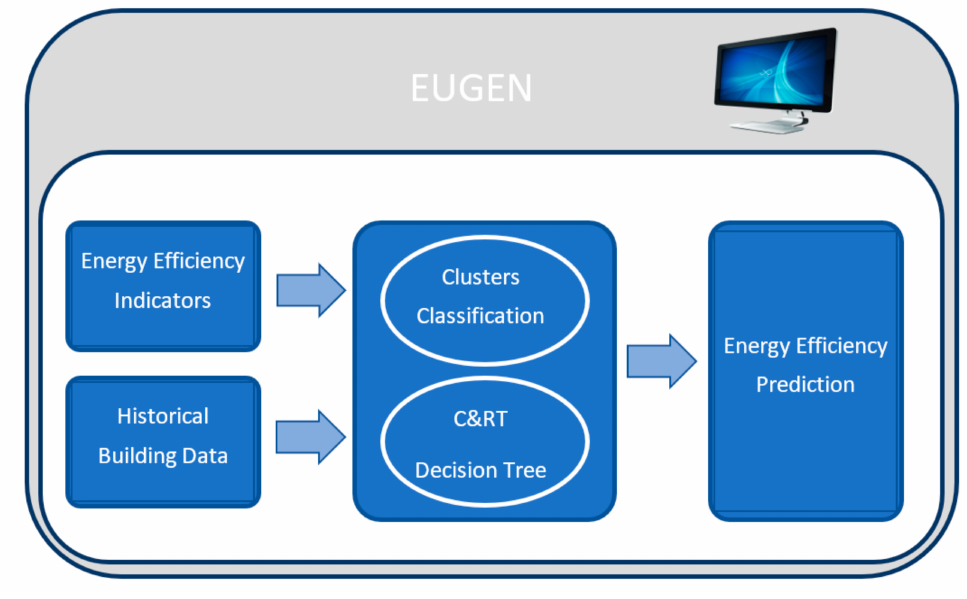
Figure 1. Prototype